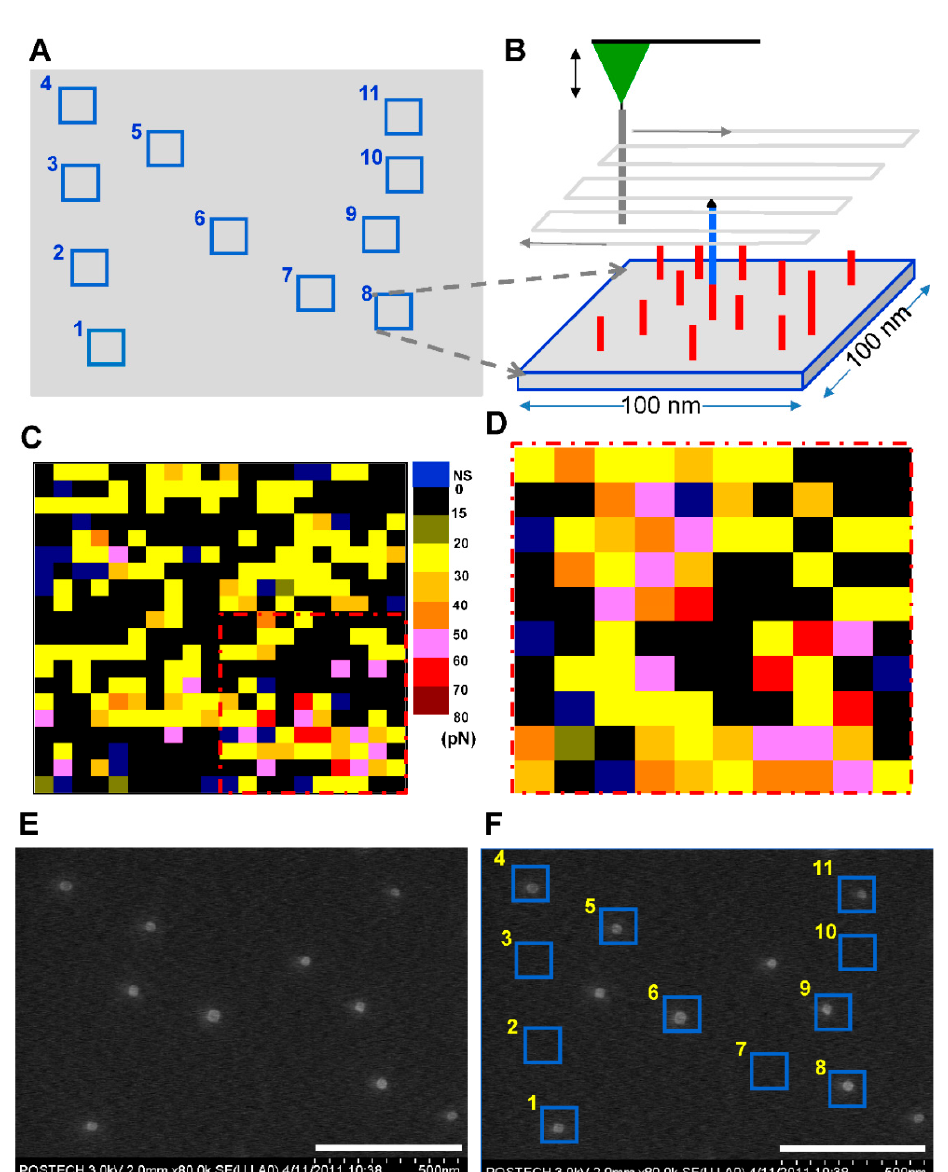
Figure 2. Visualization of the positions of the 71mer DNA. ( A ) DNA positioning map: successive single DNA nick-sealing was performed at different positions in the 1.5 μ m × 1.1 μ m area to create an N-shaped pattern. The center of each square of the positioning map was made to coincide with the point at which the single DNA nick-sealing was validated. ( B ) Scheme for AFM force mapping: an AFM tip with the c71mer DNA scanned the surface of a square depicted in ( A ) to confirm the presence of the ligated 71mer DNA with the 5 ′ -biotin. ( C ) Representative force map: the unbinding force (from 0 to 80 pN) recorded in each section of a square was indicated by the color scale. NS: non-specific unbinding force. ( D ) Force map obtained from the 2nd round of force mapping of the region dashed in red in ( C ). ( E ) SEM image of the streptavidin-coated AuNPs on the silicon substrate. ( F ) Overlap of the SEM image with the DNA positioning map. Scale bars: 500 nm in ( E , F ). An AFM tip with the c71mer DNA scanned over the region surrounding (area: 100 nm × 100 nm) each force transition point. Five force-distance curves were collected